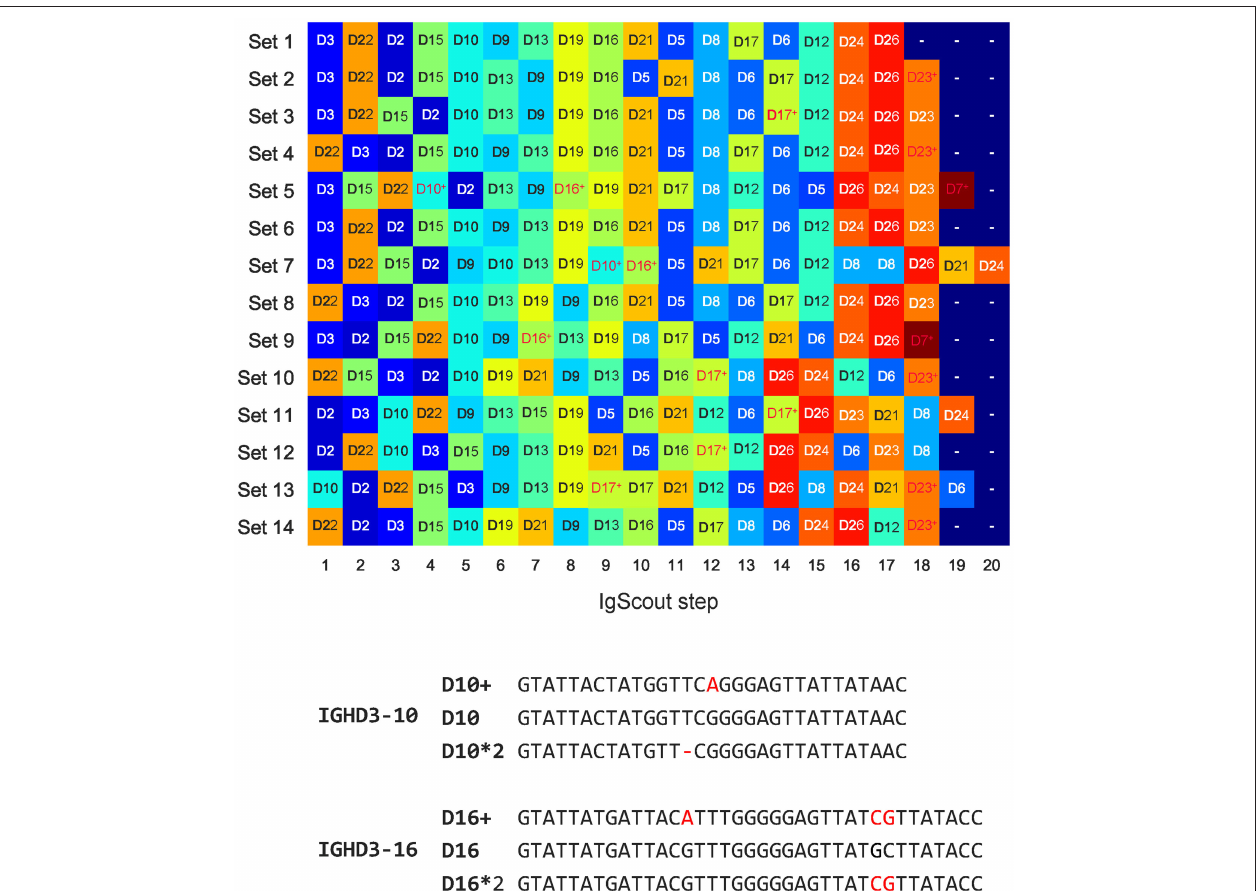
FIGURE 5 | De novo reconstructions of D genes across HEALTHY datasets (top) and allelic variants D10 + and D16 + inferred by IgScout (bottom) . (Top) Genes reconstructed at consecutive steps of IgScout for all HEALTHY datasets. Rows correspond to the datasets and columns correspond to the IgScout steps. Each cell is marked by a reconstructed D gene (each D gene is assigned a unique color). Cells marked with the “ + ” sign refer to strings that differ from known D genes by at most two nucleotides and correspond to putative novel variants (shown in red). (Bottom) Allelic variants D10 + and D16 + inferred by IgScout. Differences from human D genes and their allelic variants listed in the IMGT database are shown in